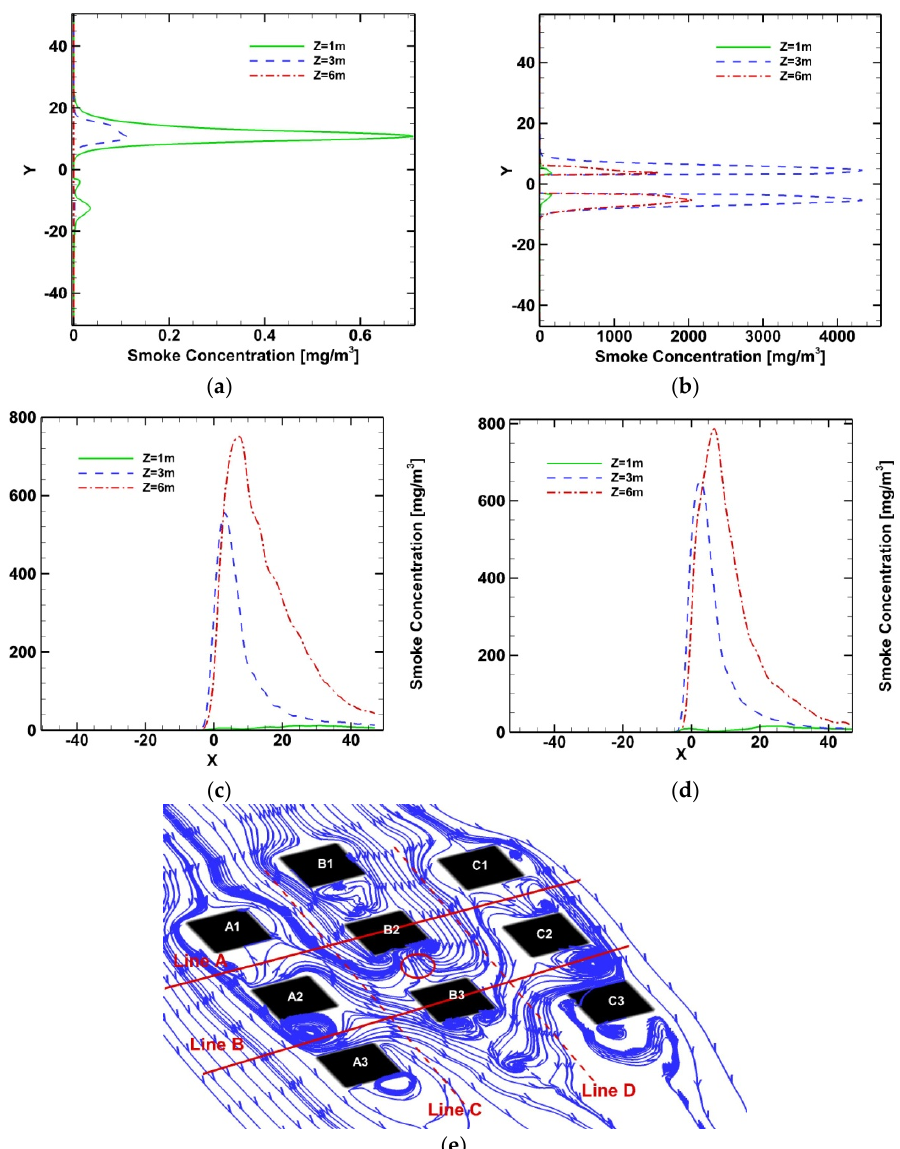
Figure 9. Smoke average concentration distribution along ( a ) A line; ( b ) B line; ( c ) C line; ( d ) D line for Case 2 and ( e ) the streamlines that define it.